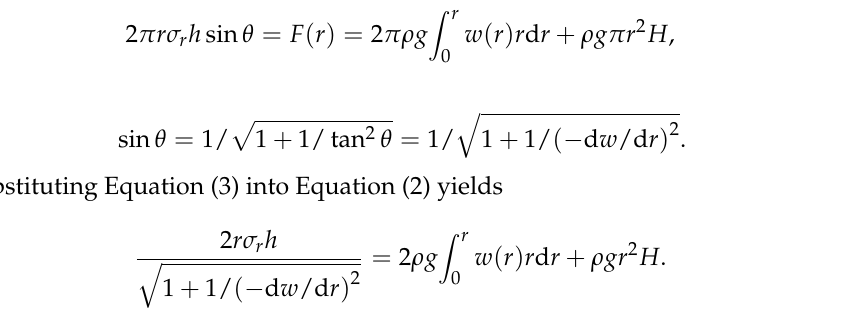
where w ( r ) is the transverse displacement of the deflected circular membrane at r , ρ is the liquid density and g is the acceleration of gravity. The direction of F ( r ) is always vertically downward, that is, is always perpendicular to the initially flat circular membrane, while the vertical upward force is equal to 2 π r σ r h sin θ , that is the vertical component of the force 2 π r σ r h at r . Therefore, after ignoring the weight of the circular membrane, the equilibrium condition where the resultant force in the vertical direction is equal to zero